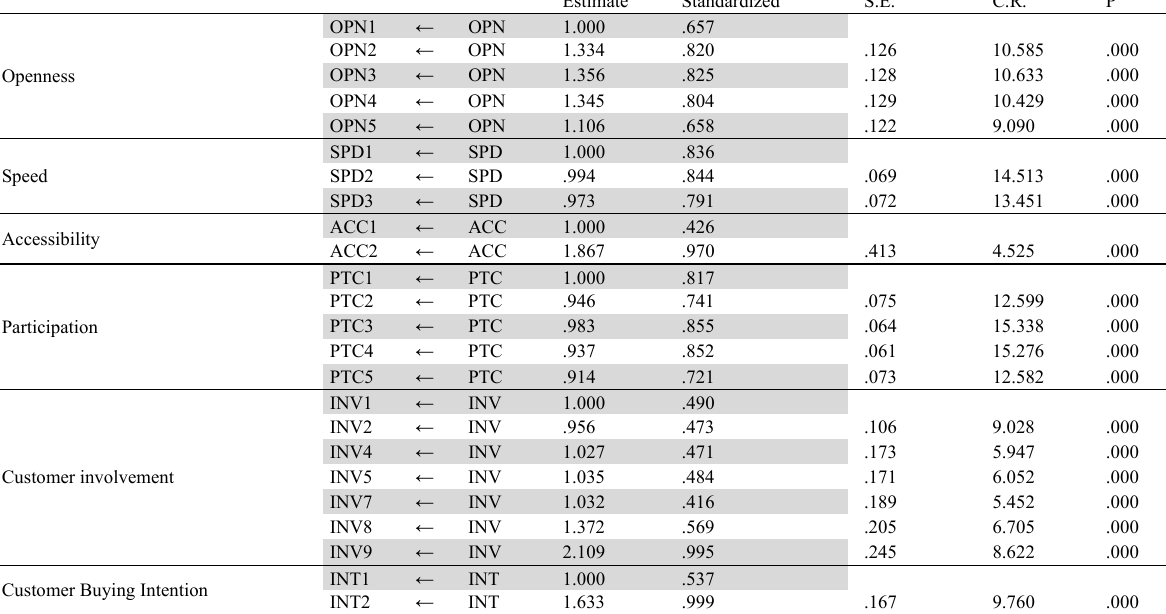
Fig. 2. Initial CFA Measurement Model Fig. 3. Final CFA Measurement Model Final CFA Measurement Model – Convergent Validity Estimate